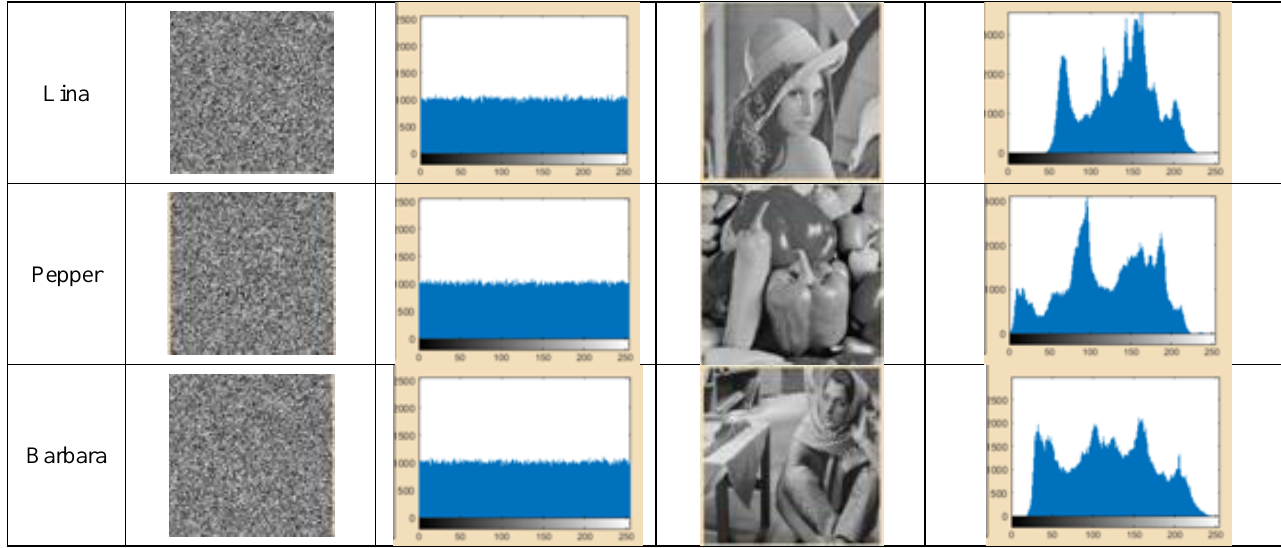
(ii) Correlation of adjacent pixels